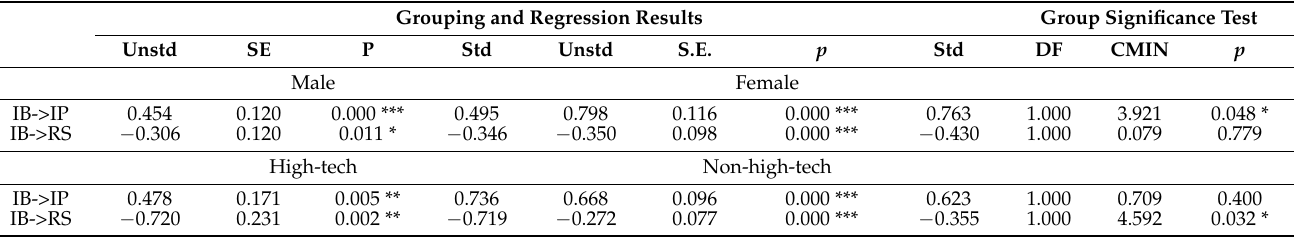
Table 7. Heterogeneity test